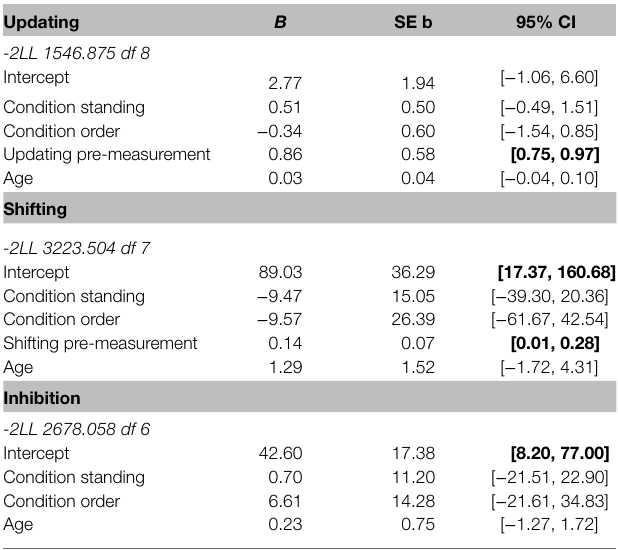
-2LL, − 2Log Likelihood; df, degrees of freedom; B = Value; SEb, Standard error; CI. Confidence interval; Significant 95% CI scores are depicted in bold; condition = standing compared to sitting; and condition order = first sit then stand or vice versa.